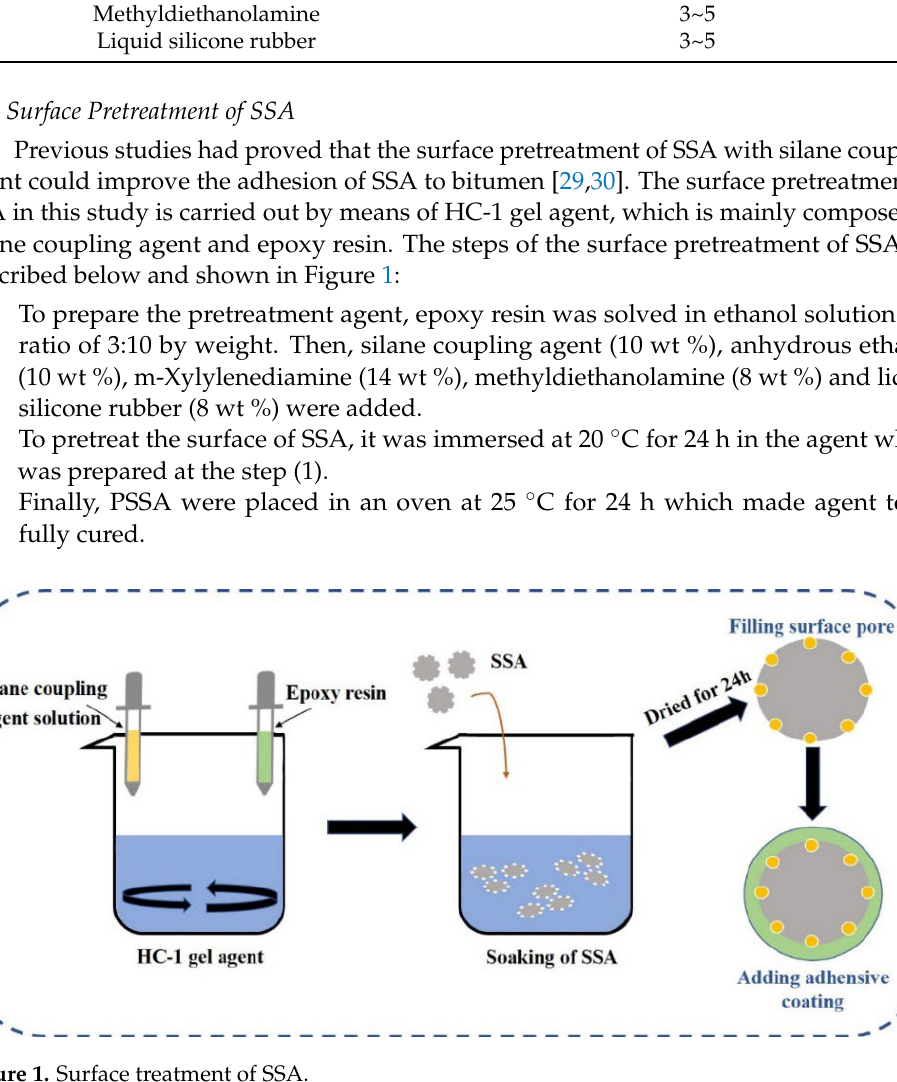
Table 3. Chemical compositions of HC-1 gel agent.